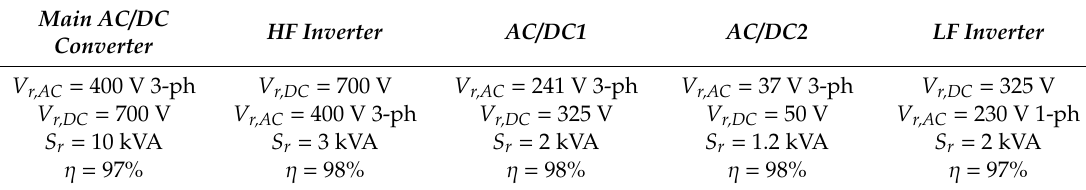
Table 2. Converter technical